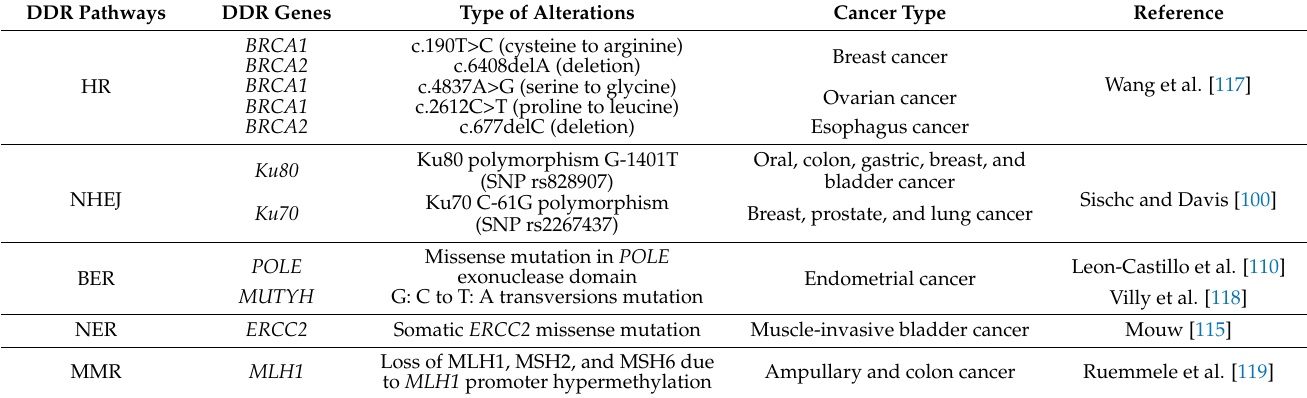
Table 1. DNA damage response alterations in several